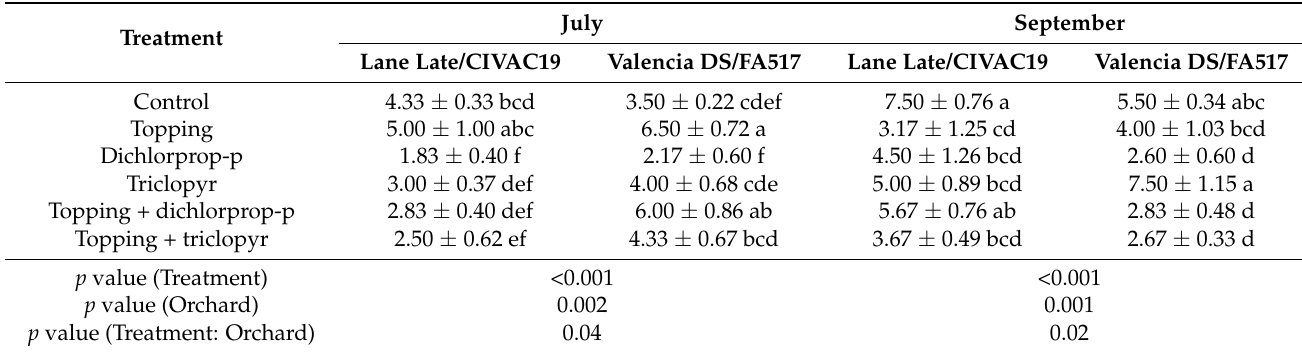
Table 1. Shoot number ± standard error (SE) under the effect of six different treatments (control, topping, dichlorprop-p, triclopyr, topping + dichlorprop-p and topping + triclopyr) in two experimental orchards with different rootstocks (CIVAC19 and Forner-Alcaide no. 517) and cultivars (‘Lane Late’ and ‘Valencia Delta Seedless’) for the evaluation of 2018.